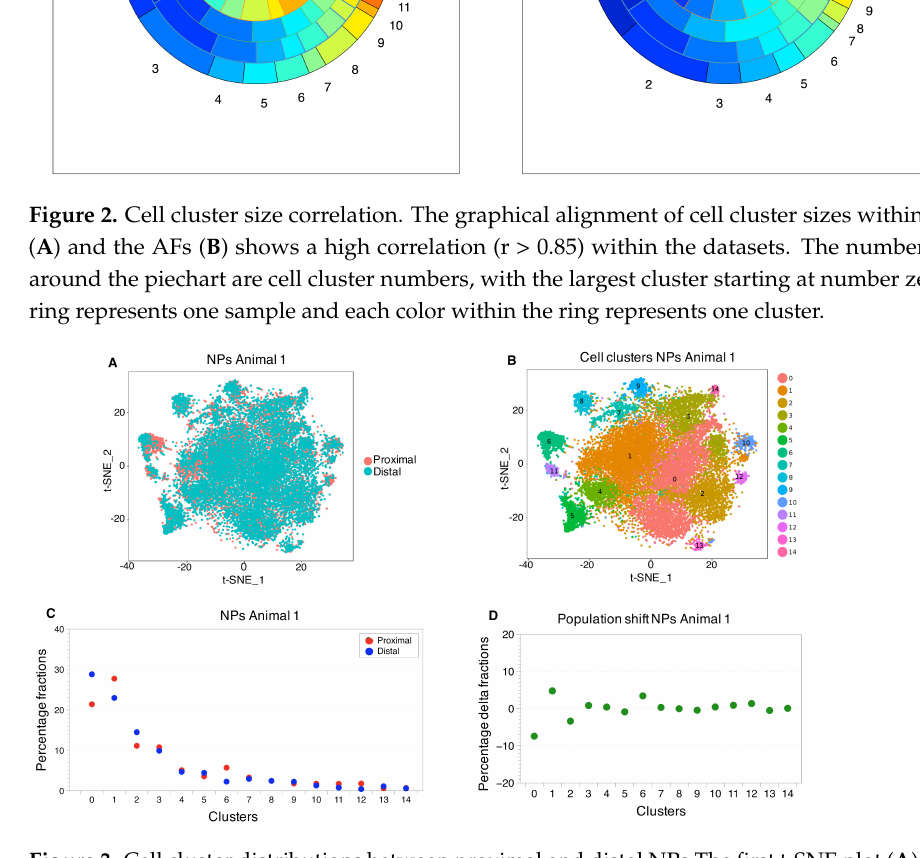
Figure 3. Cell cluster distributions between proximal and distal NPs.The first t-SNE plot ( A ) provides a visual measure for similarity for the proximal and distal NPs. The graphical overlap stands for the amount of similarity in gene expression profiles of the distal and proximal NPs. The second t-SNE plot ( B ) shows the identified cell clusters. ( C ) The population sized within a cell cluster. The first dot plot ( C ) is a representation of the percentage of the fractions of cells per cluster, normalized to the total amount of cells in each corresponding sample (see Table S1 for the original data). The population shift observed between the proximal and the distal samples, is described in terms of number of cells that compose a cluster in each sample. ( D ) The difference in percentage between the cell cluster sizes of the proximal and distal NPs, indicating the amount of correlation between the samples. (Animal 2, in Figure S2 and Table